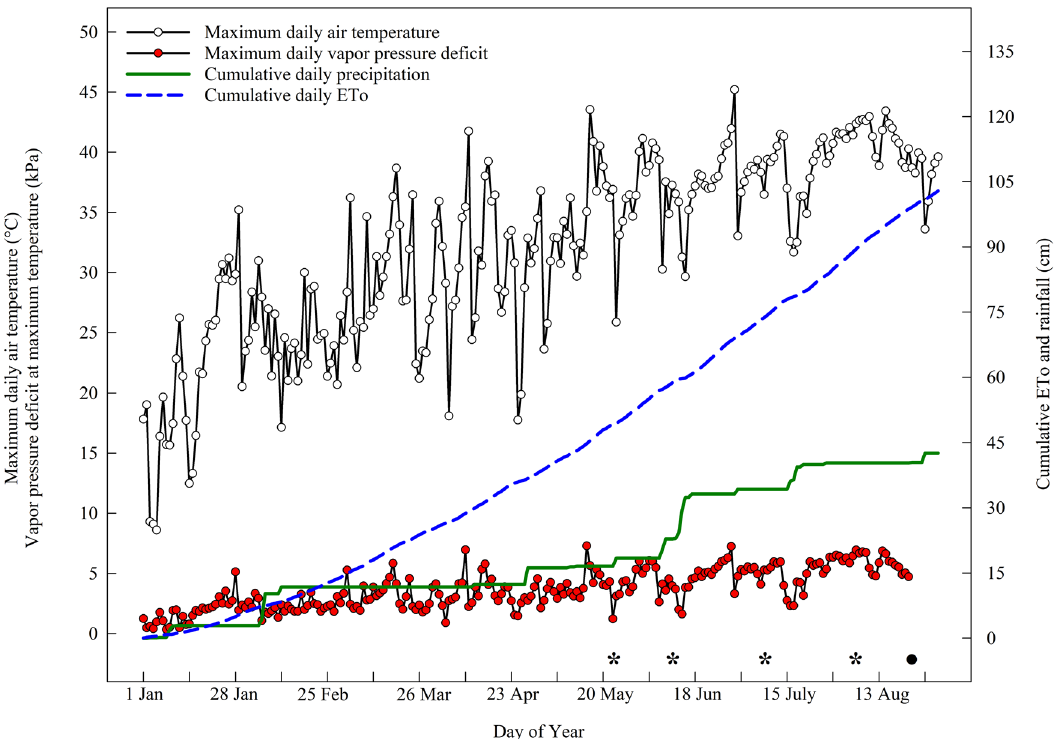
Figure 2: Maximum daily air temperature, VPD at maximum daily air temperature, cumulative reference evapotranspiration ( ET O ) , and cumu - lative rainfall data ( 1 January – 31 August ) for olive ( Olea europaea L. cv. “ Arbequina ” ) Orchard 3 ( located near Artesia Wells, TX ) during the second growing season. Asterisks indicate dates leaf gas exchange data were collected. Circular symbol indicates fruit harvest